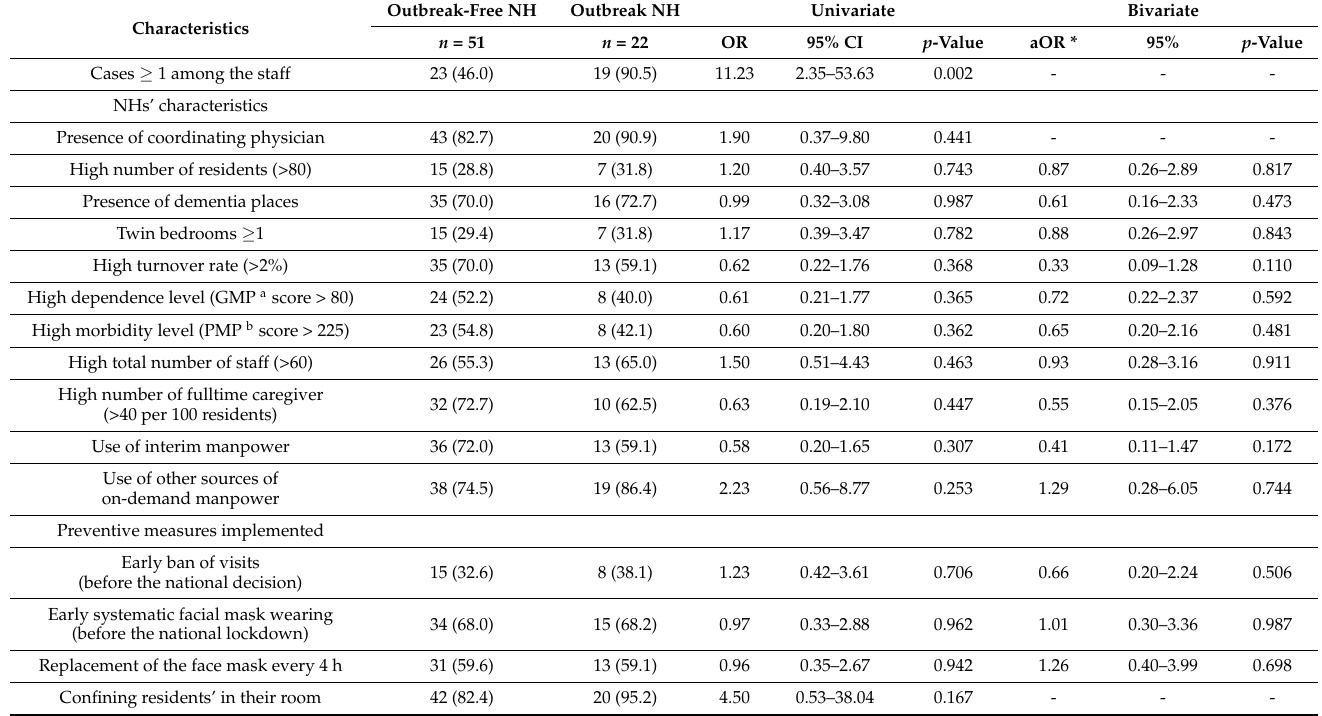
Table 3. Associations between nursing home characteristics and the occurrence of outbreaks ≥3 cases among the residents, adjusted on the occurrence of cases ≥1 among the staff.